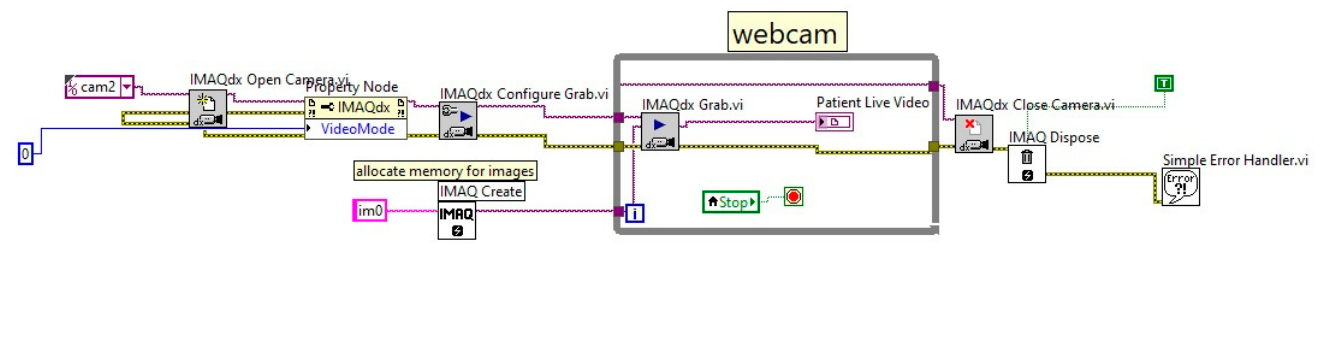
Figure 6. GUI for the real-time monitoring of the patient.